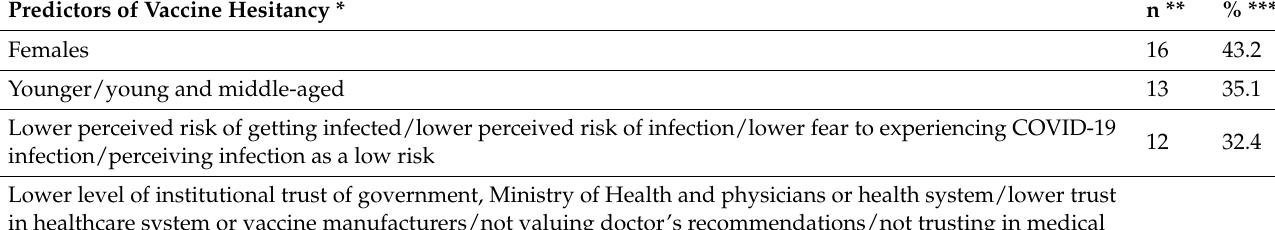
Table 5. Global predictors of vaccine